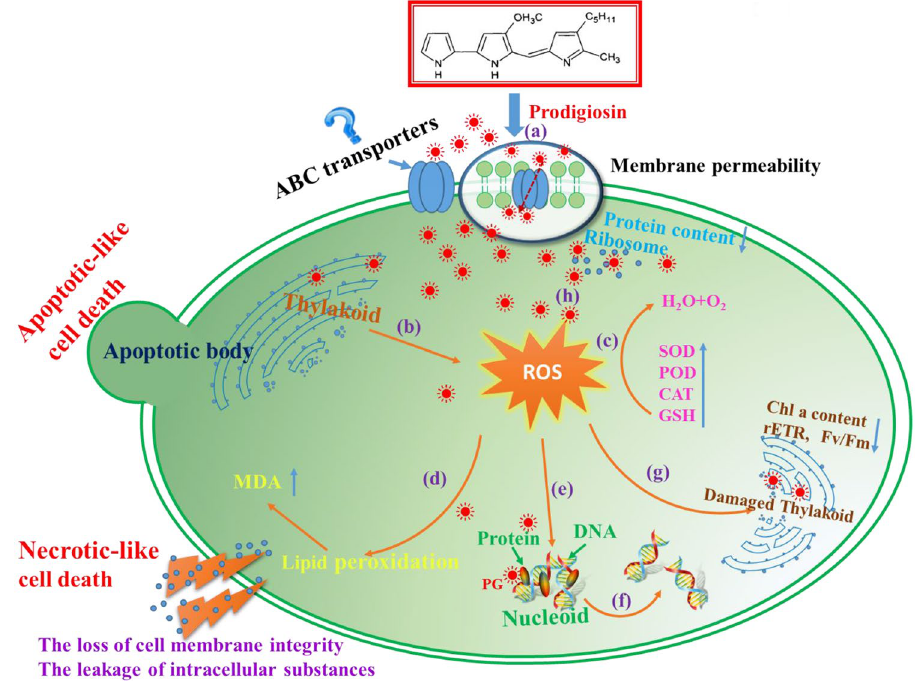
Figure 12. A schematic diagram depicting the mechanism of algal cell death under PG stress. ( a ) PG may be transferred across the cell membrane by ABC transporters; ( b ) PG likely stimulates photosynthesis to generate excess ROS; ( c ) the antioxidant system, including GSH, SOD, POD and CAT, are activated to scavenge ROS; ( d ) the excess ROS could lead to lipid peroxidation, and the cellular membrane permeability and integrity are damaged, which likely results in necrotic-like cell death; ( e ) PG may bind to nucleotides, especially purine (ribo)nucleosides, and the excess ROS could cause DNA damage; ( f ) the damaged DNA may be partially repaired by the nucleotide excision repair system; ( g ) the excess ROS could disrupt the thylakoid membrane and inhibit photosynthesis as the treatment time increases; ( h ) PG may target the ribosomes, which could interfere with protein